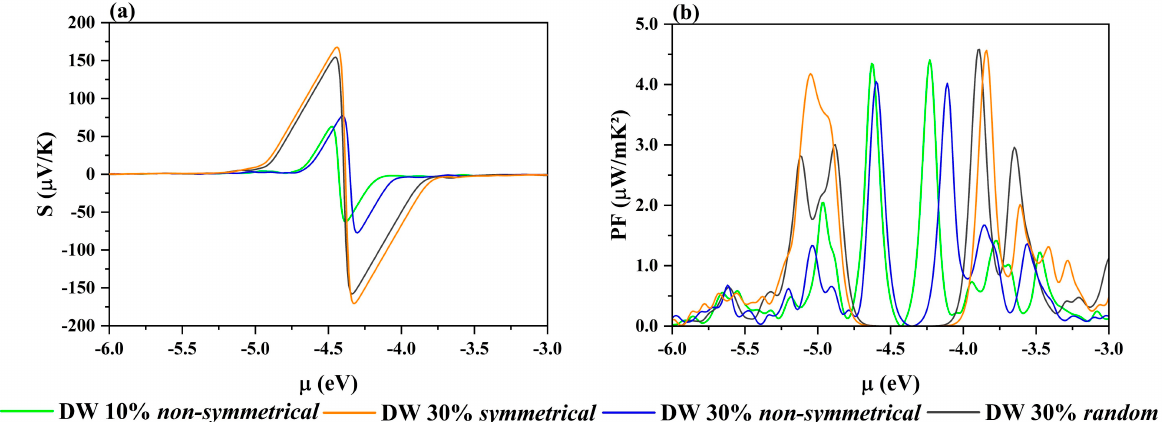
Figure 5. ( a ) Seebeck coefficient (µV/K) and ( b ) power factor (µW/mK 2 ) for 30% BN-doped DW structures, C@(BN) 0.3 C 0.7 . Symmetrical : orange; random : gray; non–symmetrical: blue. For the sake of comparison, the C@(BN) 0.10 C 0.90 non–symmetrical is also added, in green.